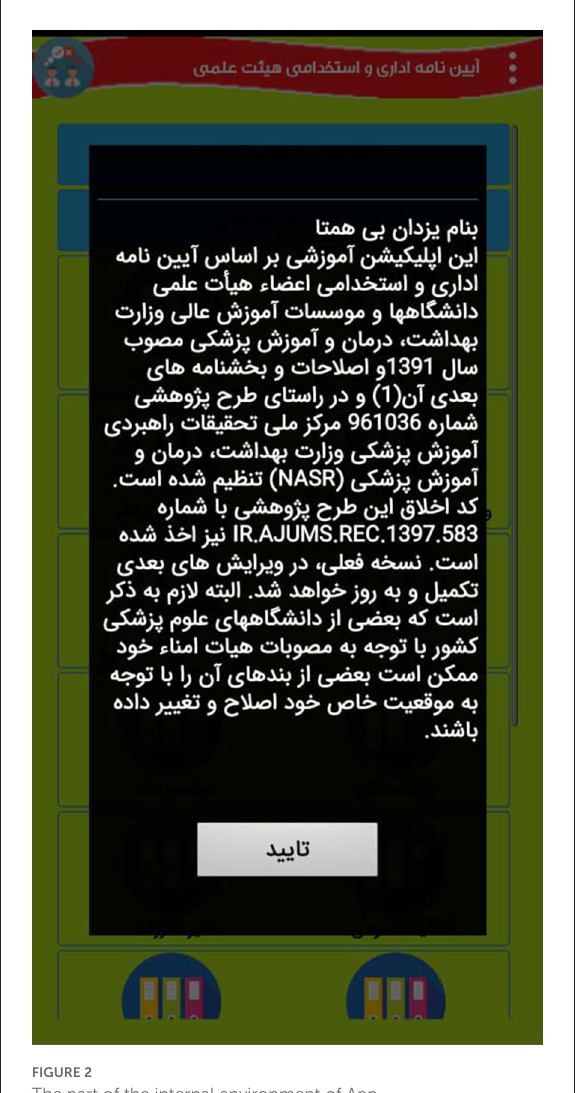
FIGURE2 The part of the internal environment of